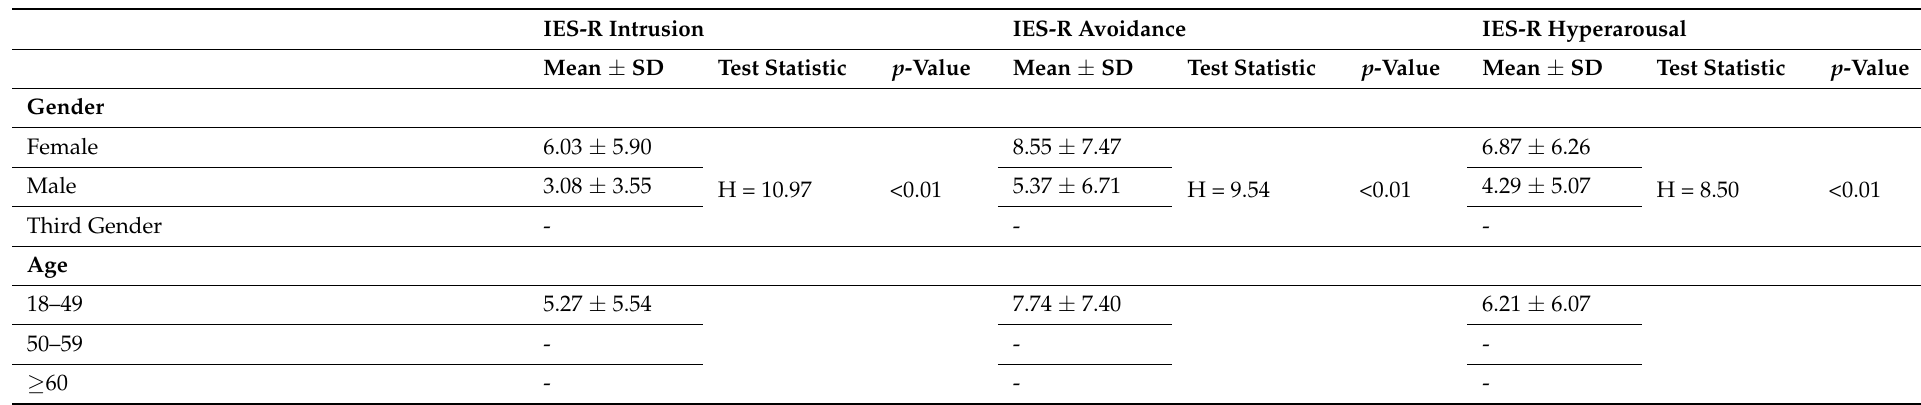
Table 5. Differences between participants’ characteristics regarding IES-R subscale